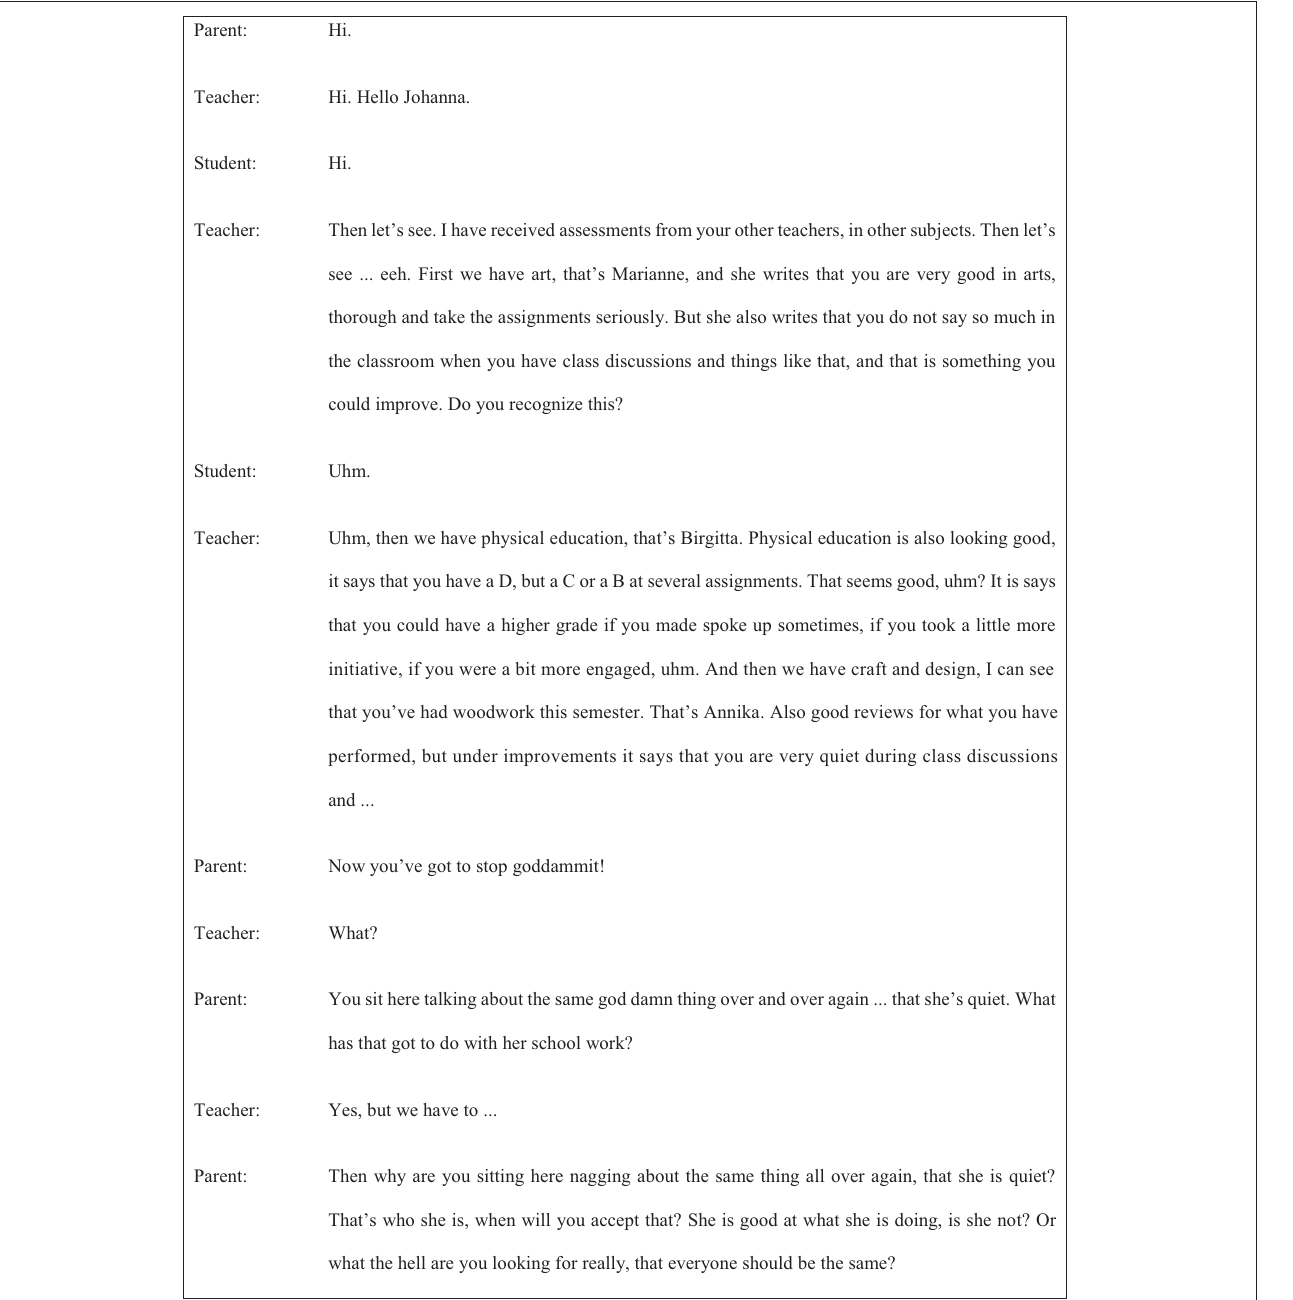
emotions within each group. These emotions are not viewed as being inherently positive or negative, but rather as messengers reflecting the qualities of interpersonal relationships. With the aid of Scheff’s theory, a more nuanced description can be made of teachers’ relational competency. Scheff holds that attunement is crucial for understanding the quality of the social bond in interpersonal communication. Relationally